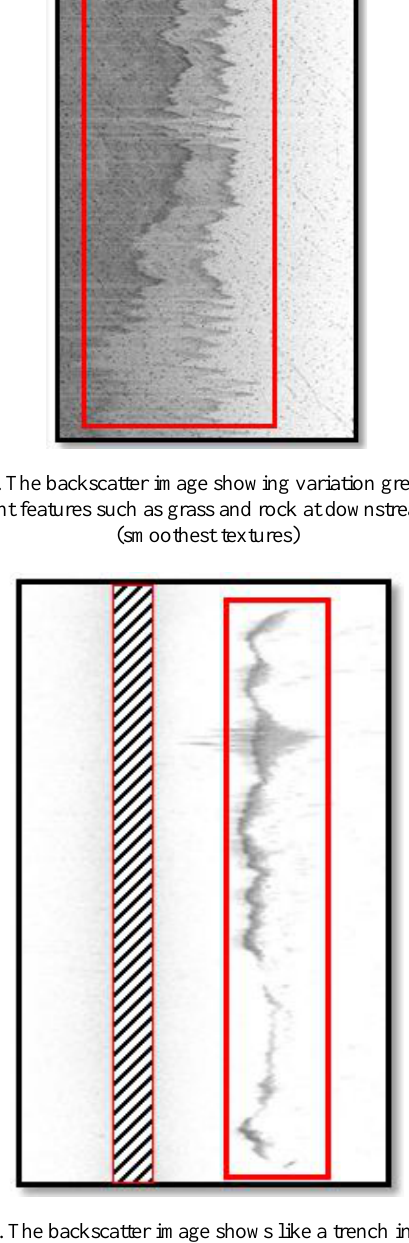
Figure 6. The backscatter image shows like a trench in the river bed downstream area (smoothest textures) extracting seabed properties directly from digital side scan